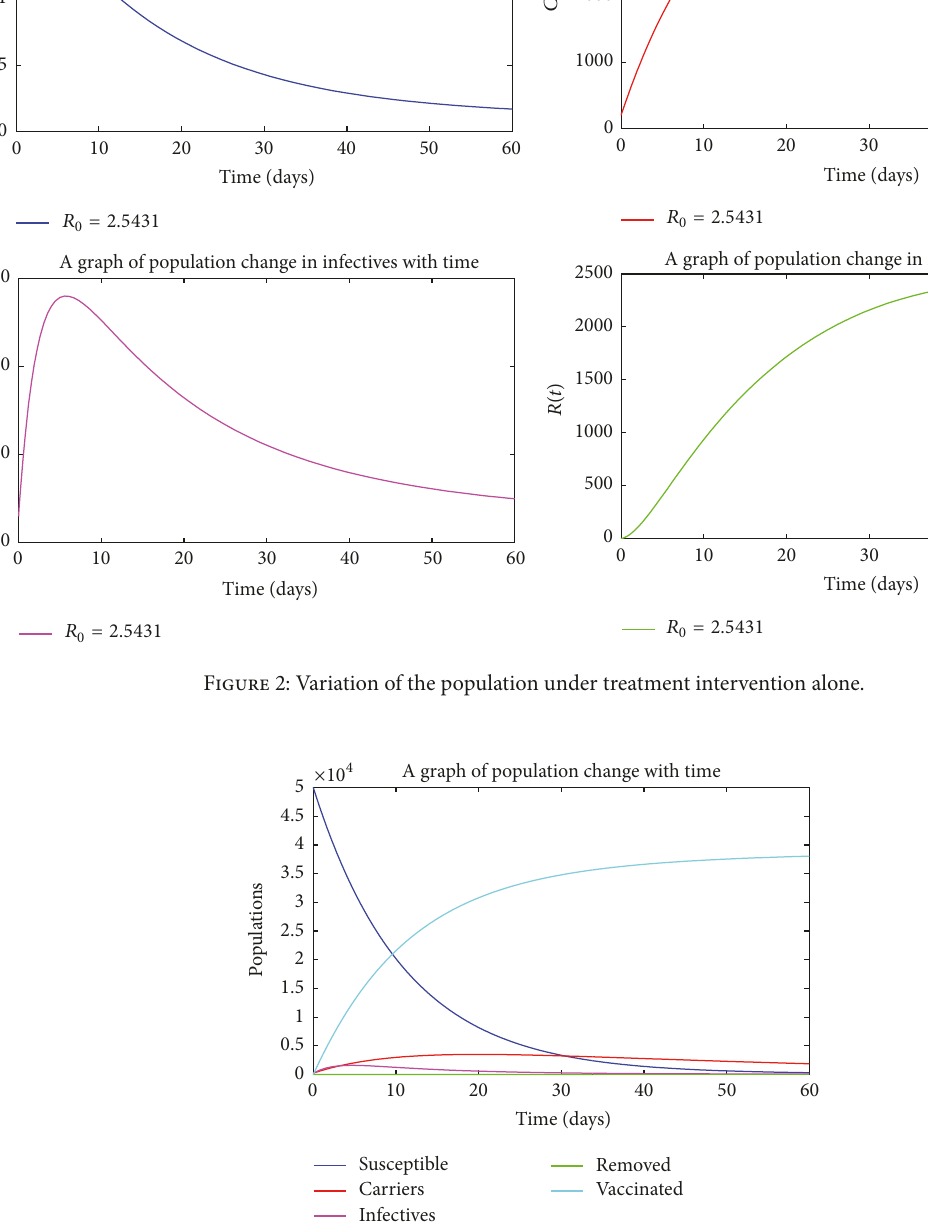
Figure 3: Variation of the population under treatment and vaccination